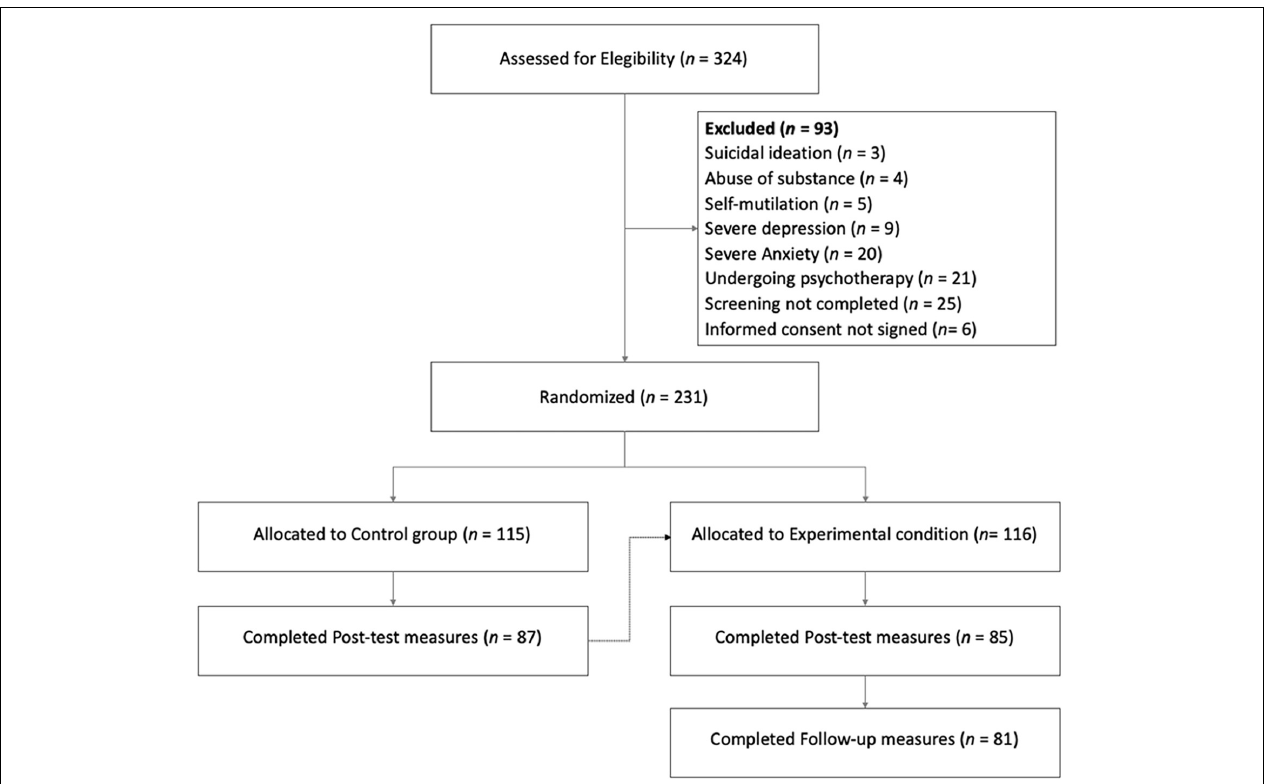
FIGURE 1 | Participants’ flow from screening to